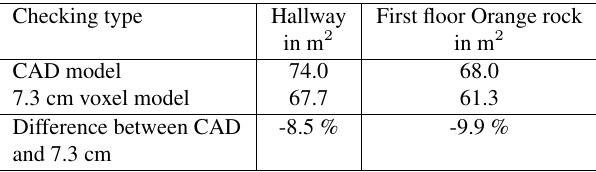
Table 2. Area of the CAD model and the identified floor spaces with an voxel size of 7.3 and 3.7 cm